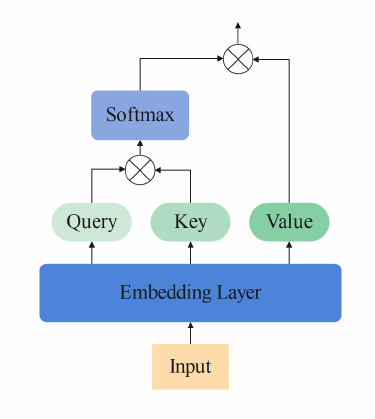
Figure 1. The computing operation of